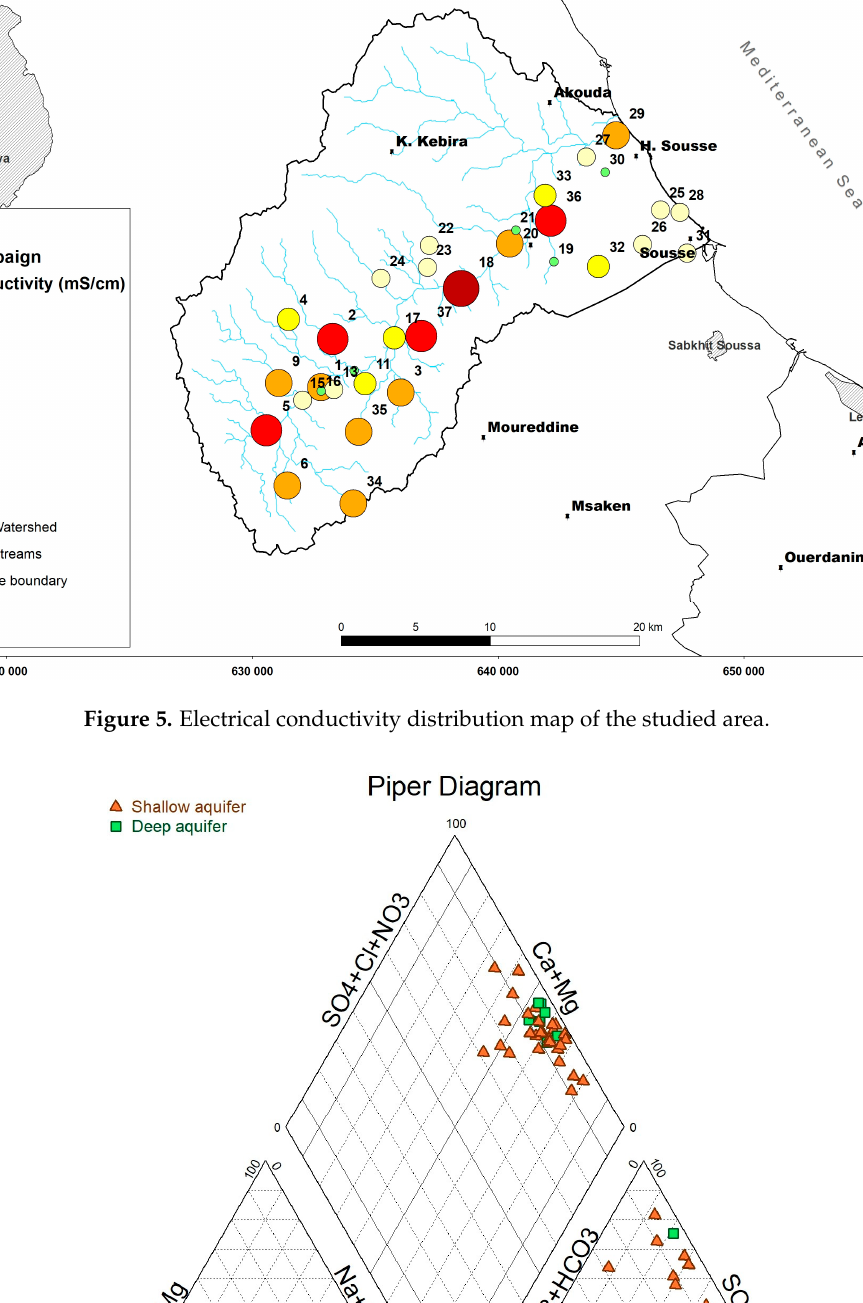
Figure 6. Piper diagram drawn for shallow and deep aquifer.